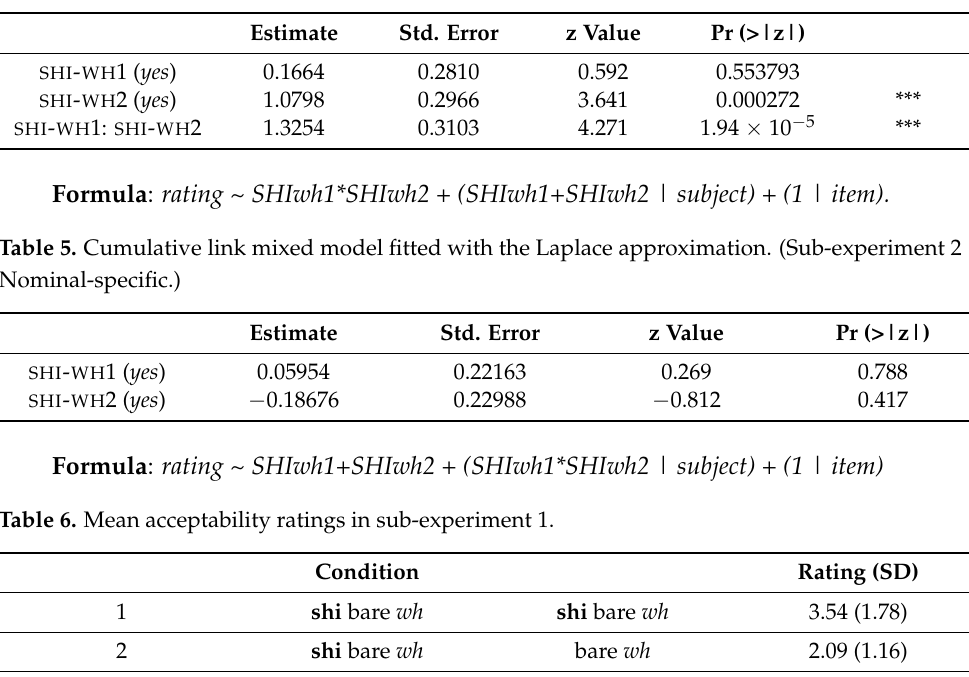
Figure 3. Mean acceptability rating (n = 28). Error bars show 95% confidence interval.